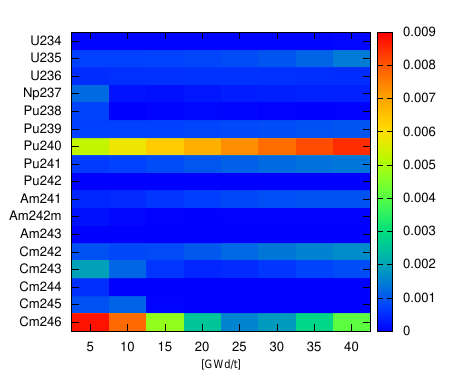
Figure 14. Reduction of the RFs when making individual weights zero (target: k at 40 GWd / t, Case ∞